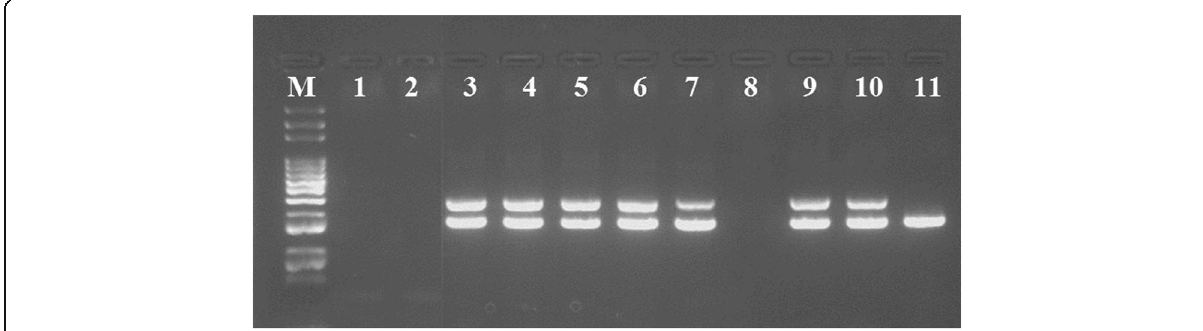
Fig. 1 Gel electrophoresis for detection of gr/gr deletion. Lane 1, no template control; lane 2, female patient; lanes 3 – 7, 9, and 10, normal genotype; lane 8, deletion of both markers; lane 11, no sY1291 marker detected, which indicates a gr/gr deletion; M, 1 kb DNA